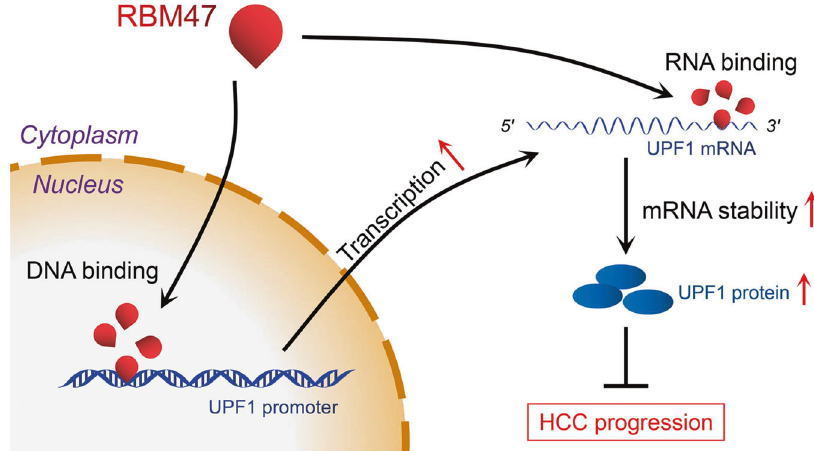
Fig. 9 Schematic of the proposed mechanism by which RBM47 inhibits HCC progression. As an RNA binding protein, RBM47 elevated UPF1 mRNA by binding to the UPF1 3 ’ UTR to enhance its stability. Meanwhile, RBM47 directly bound to the promoter of UPF1 as a DNA binding protein to promote UPF1 transcription. Thus, RBM47 suppressed HCC progression by enhancing UPF1 as a DNA/RNA regulator. HCC Hepatocellular carcinoma, RBM47 RNA-binding motif protein 47, RBP RNA binding protein, UPF1 Up-frameshift 1, NMD nonsense-mediated RNA decay, TF transcription factor, IHC Immunohistochemistry, IF Immuno fl uorescence, RIP RNA immunoprecipitation, RPKM Reads Per Kilo bases per Million reads, ChIP Chromatin immunoprecipitation, pre-mRNA precursor mRNA, TSS transcription initiation site, RRM RNA recognition motif, AS alternative